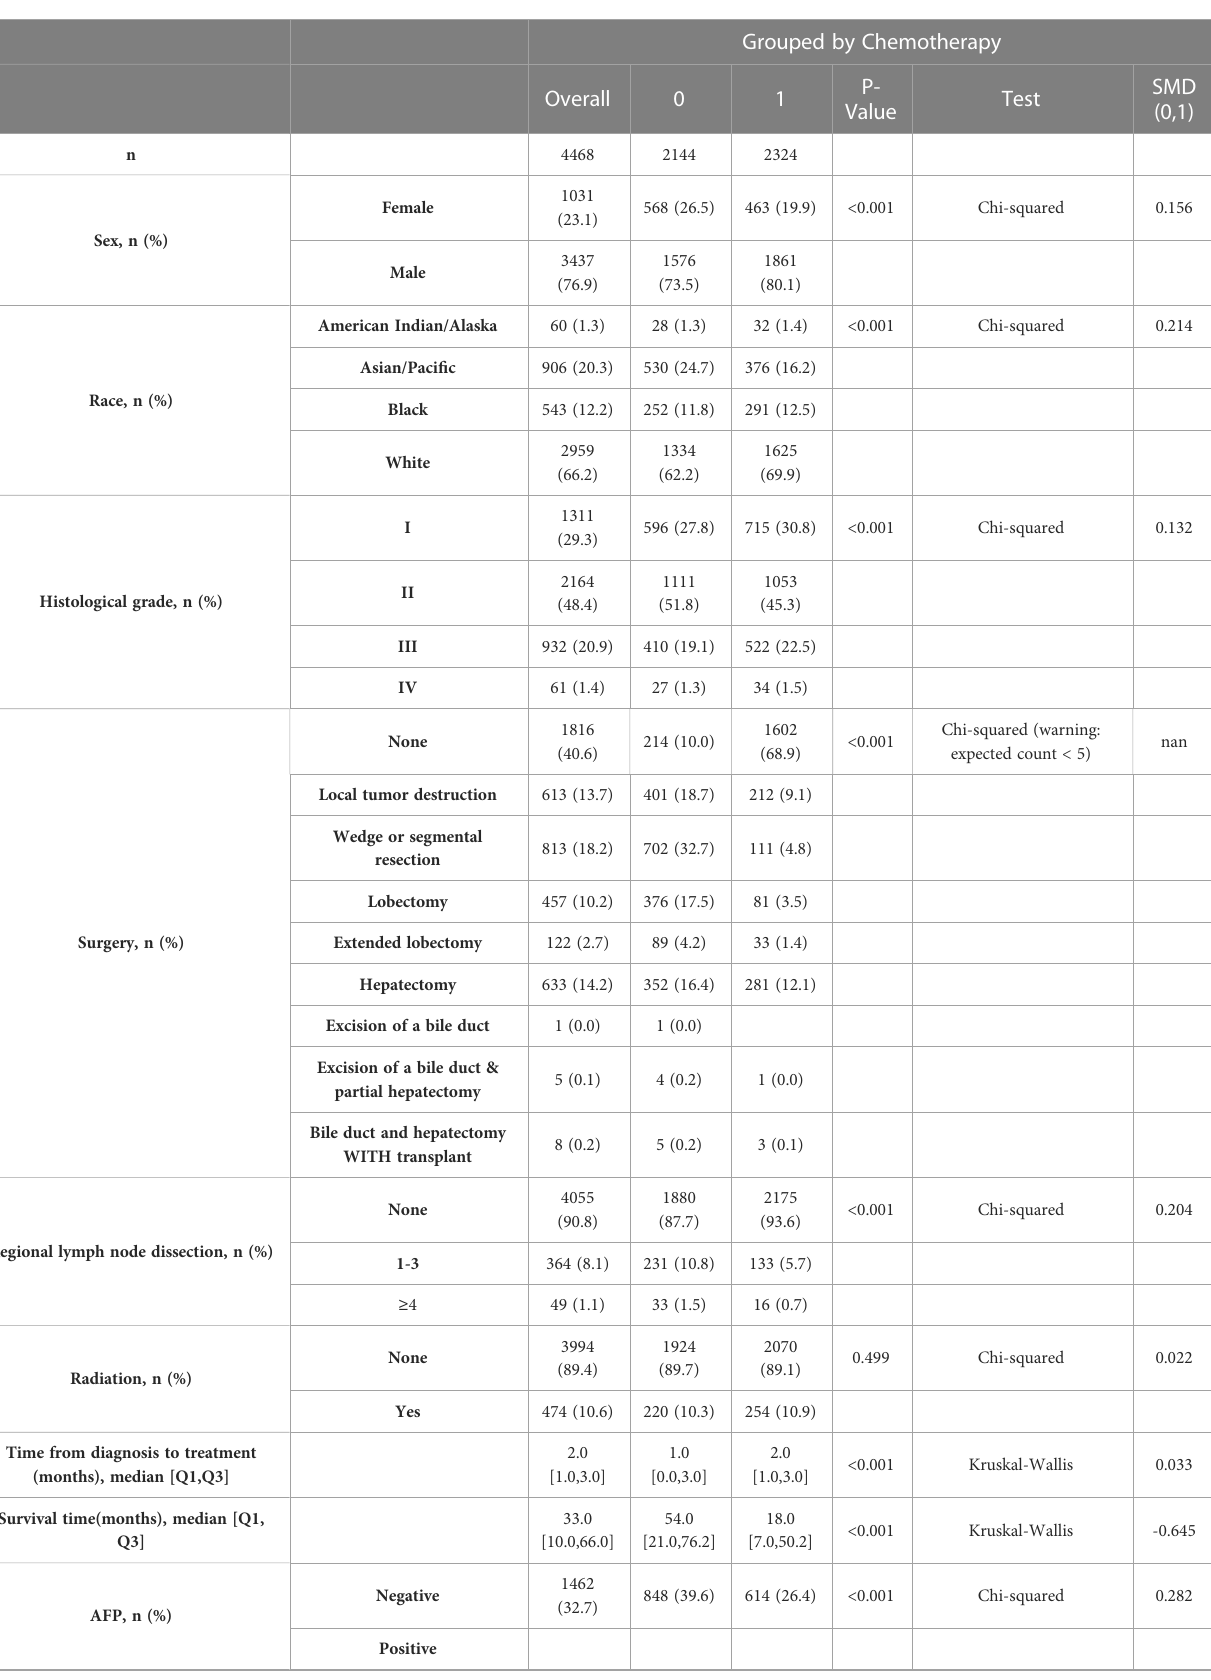
TABLE 1 Clinical